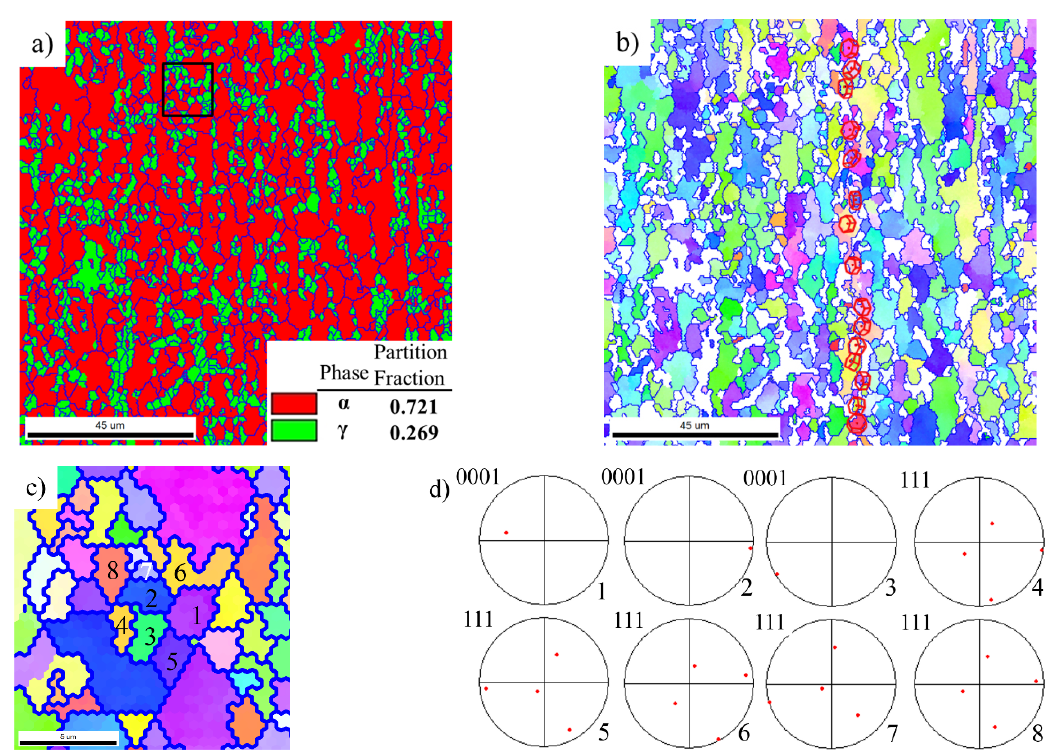
Figure 3. EBSD analysis of the quenched microstructure after three isothermal compression cycles at 1250 °C/0.1 s − 1 /25%: ( a ) phase fraction, orientation map of ( b ) α phase, ( c ) orientation map of the black region in ( a ) and ( d ) pole figure of each grain in ( c ).